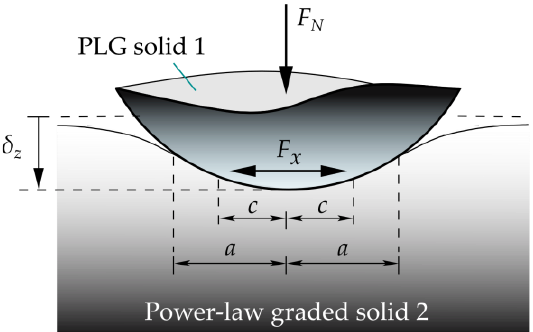
Figure 1. Partial slip contact between two axisymmetric power-law graded elastic solids (tangential fretting mode).